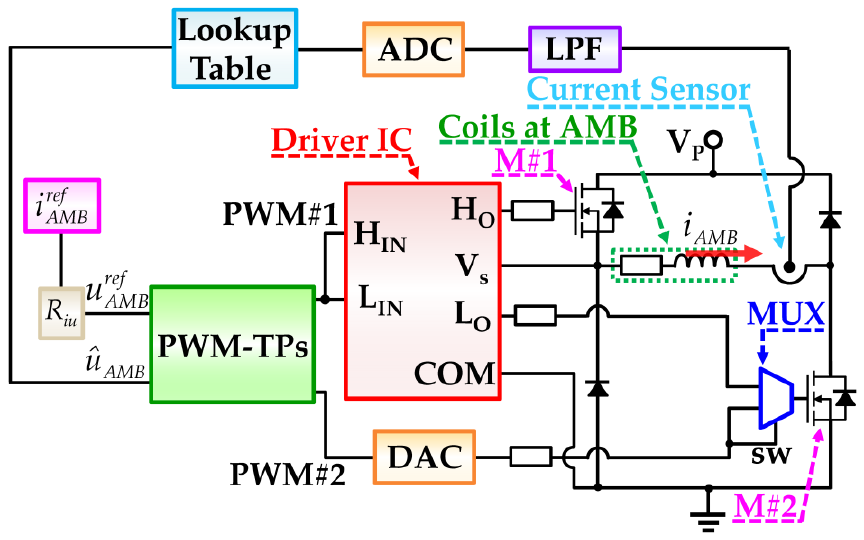
Figure 1. Circuit configuration of DC 2 (dual cooperative drive circuit).